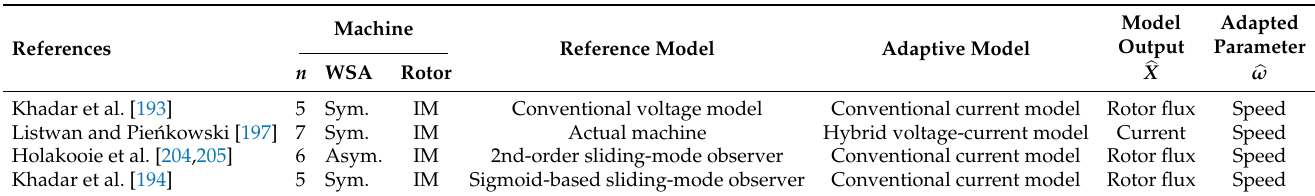
Table 18. Speed/position-sensorless methods based on MRAS (Section 7.3.1.7) in multiphase applica- tions in the